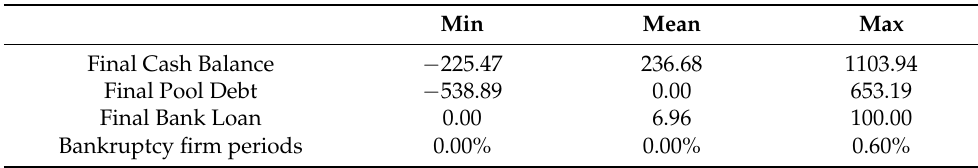
Table 12. Results for diverse operational risk with cooperation.